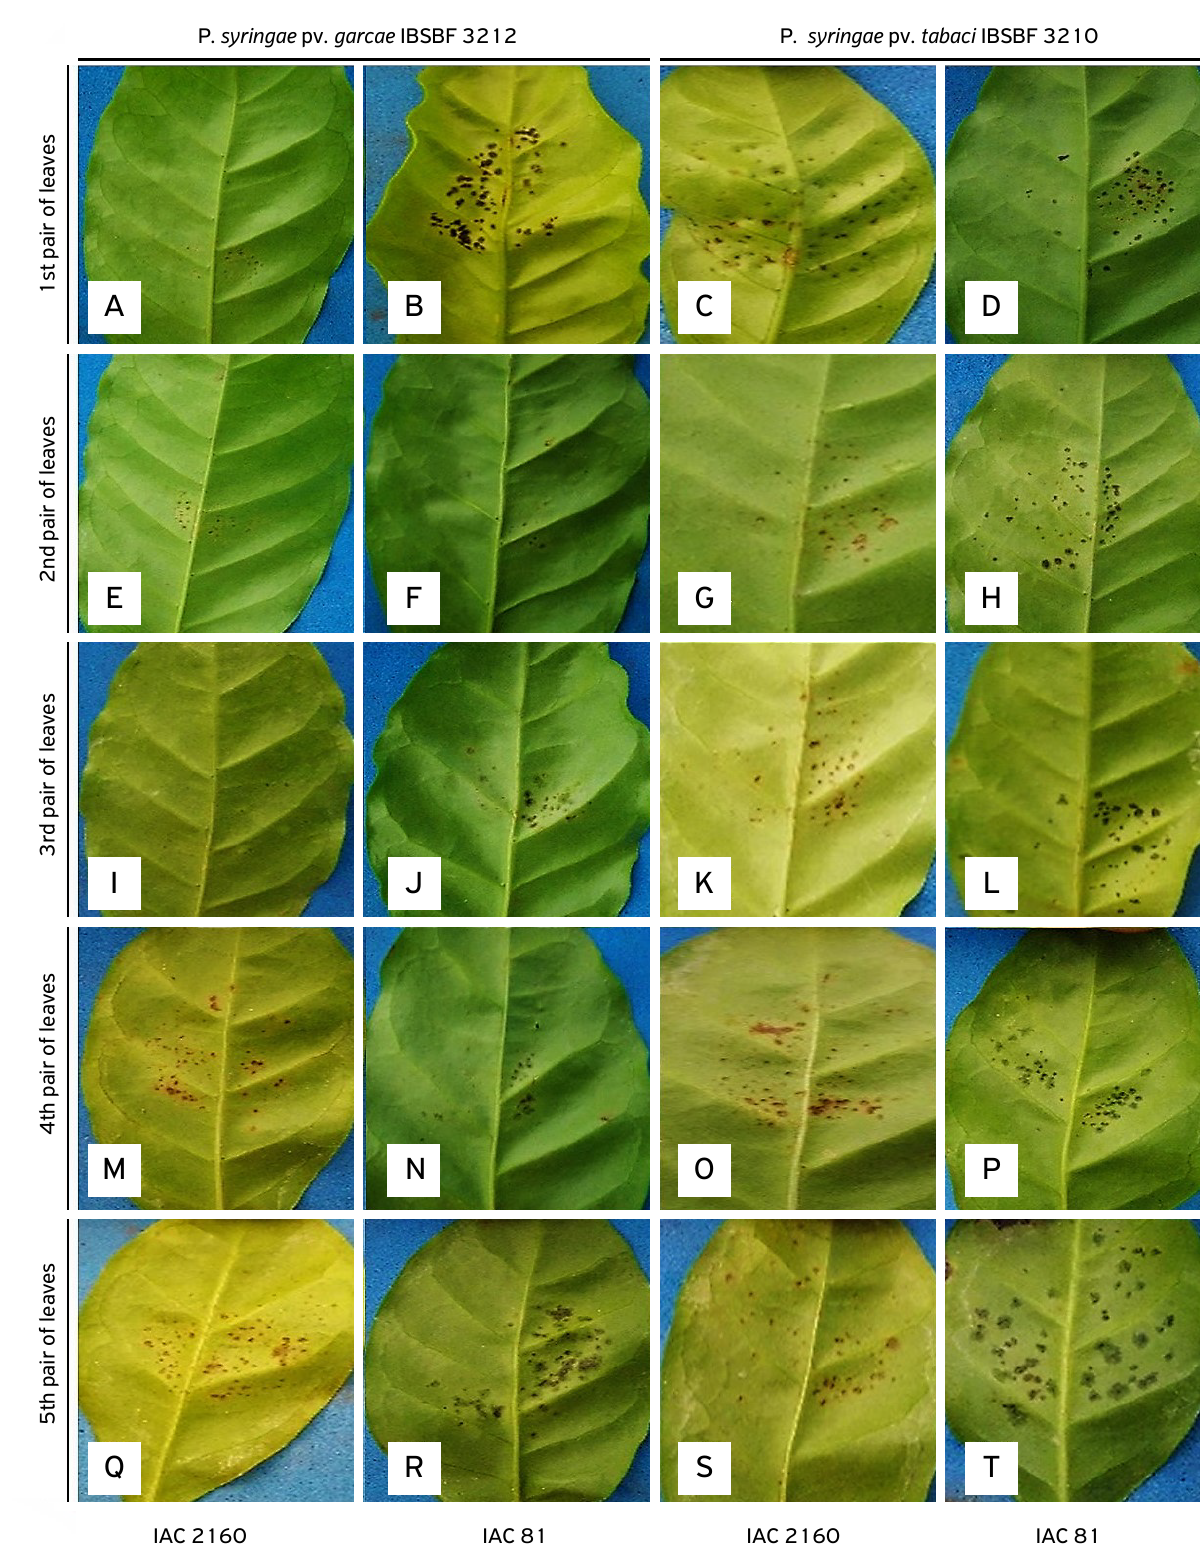
Figure 1. Symptoms at seven days after inoculation on leaves of the first to fifth internodes, inoculated by the abrasion method with Pseudomonas syringae pv. garcae , strain IBSBF 3212 (A, E, I, M and Q) on Coffea arabica IAC 2160 land race, and on leaves of the susceptible Catuaí Vermelho IAC 81 cultivar (B, F, J, N and R). Besides, inoculated with P. syringae pv. tabaci IBSBF 3210 strain, on leaves of IAC 2160 (C, G, K, O and S) resistant access, and on leaves of the susceptible Catuaí Vermelho IAC 81 cultivar (D, H, L, P and